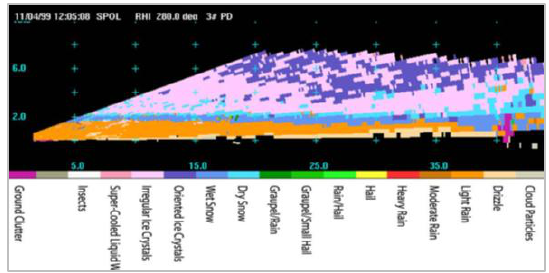
Figure 8 . Discrimination of hydrometeors types by